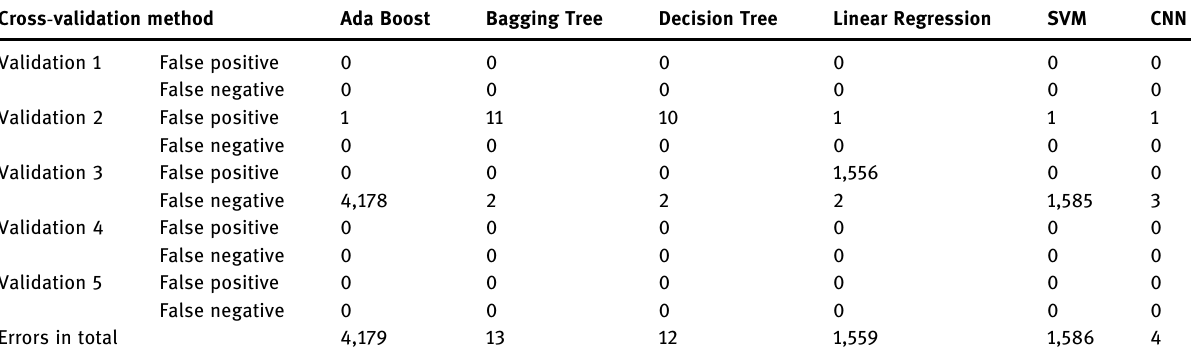
Table 2: Cross validation results of each method Cross - validation method